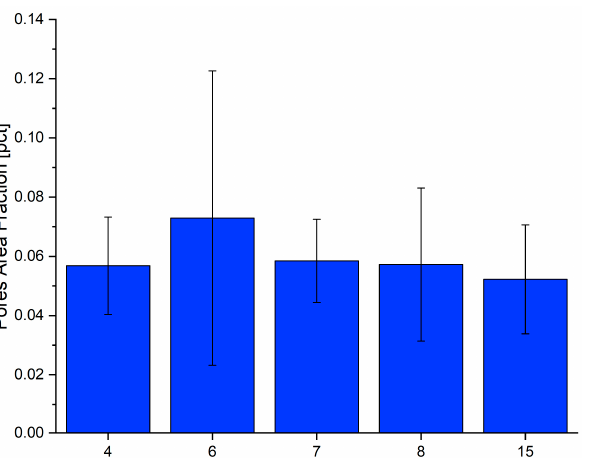
Figure 11. Mean values and standard deviations of the pore area fraction measured among different prints.